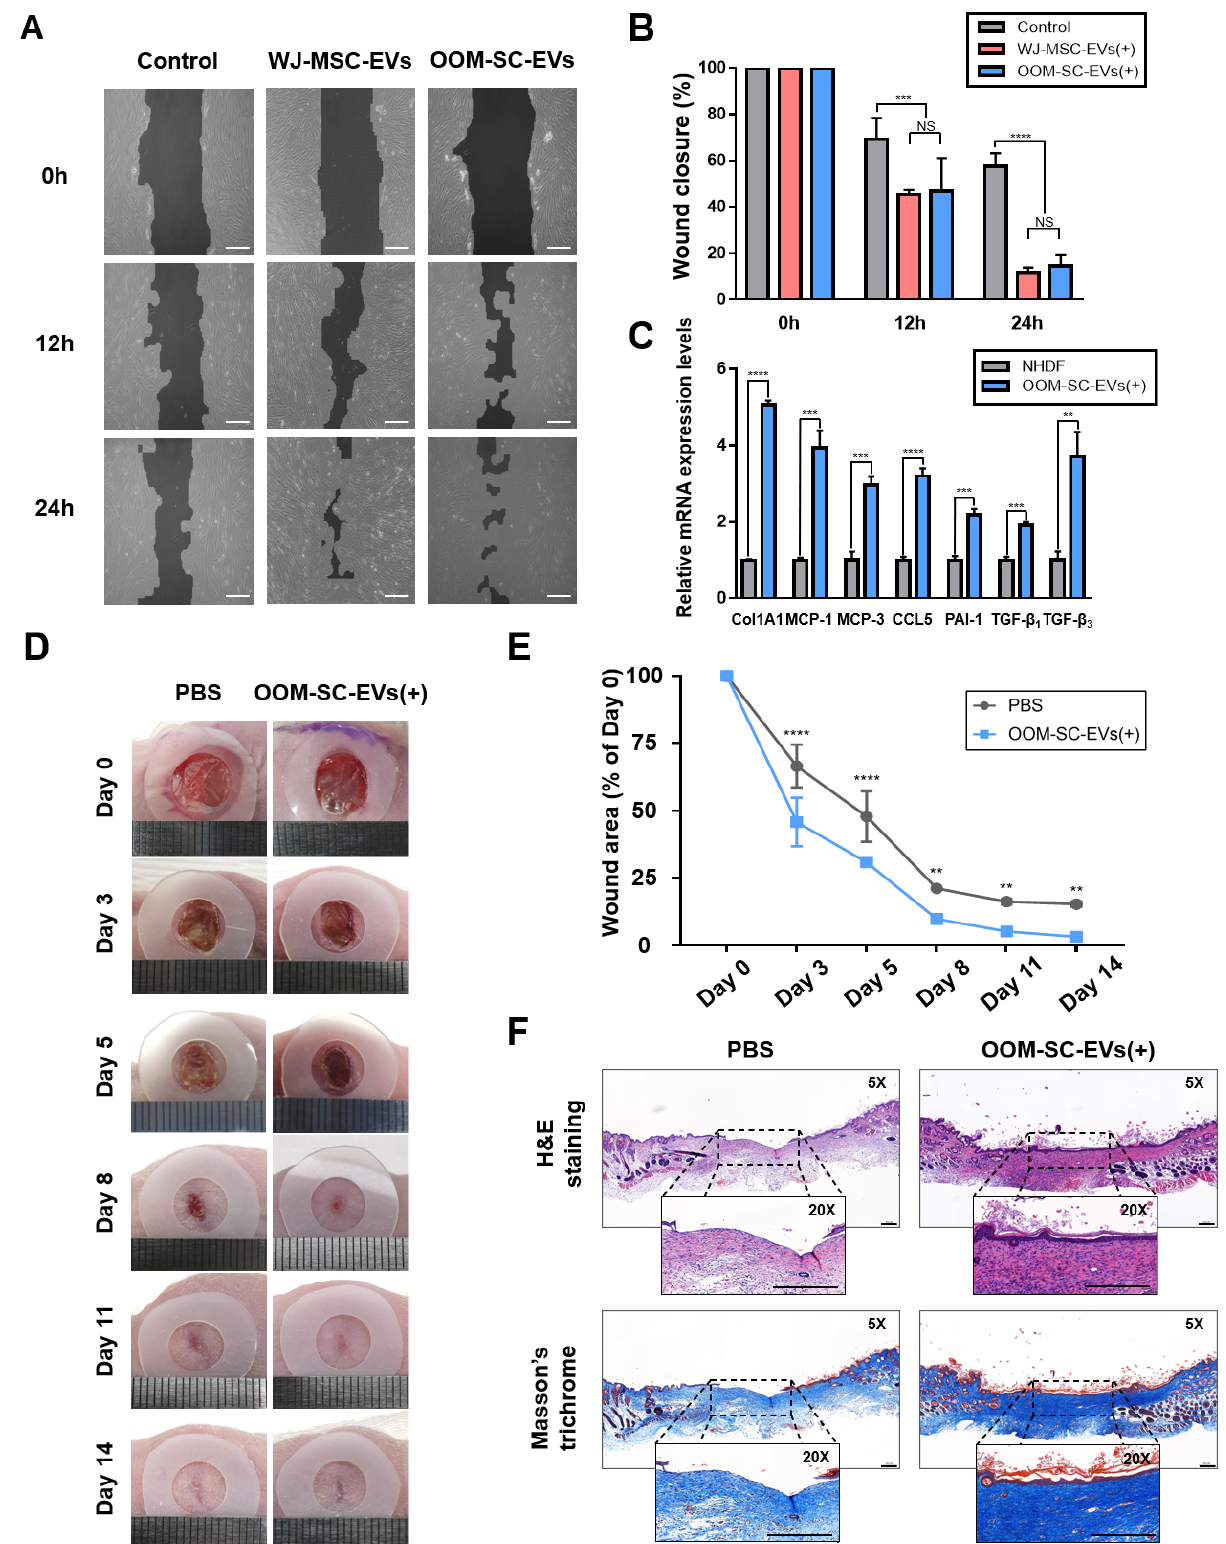
Figure 6. In vitro and in vivo wound healing capacities and the anti-wrinkling activity of the OOM-SC-EVs ( A ) Effect of OOM-SC-EVs in the closure of in vitro scratches of fully confluent NHDFs tablet 10. μ g/mL mitomycin C for 2 h and then scratched with a 200- μ L tip. Subsequently, cells were exposed to 1.5 × 10 9 particles of OOM-SC-EVs or WJ-MSC-EVs in a